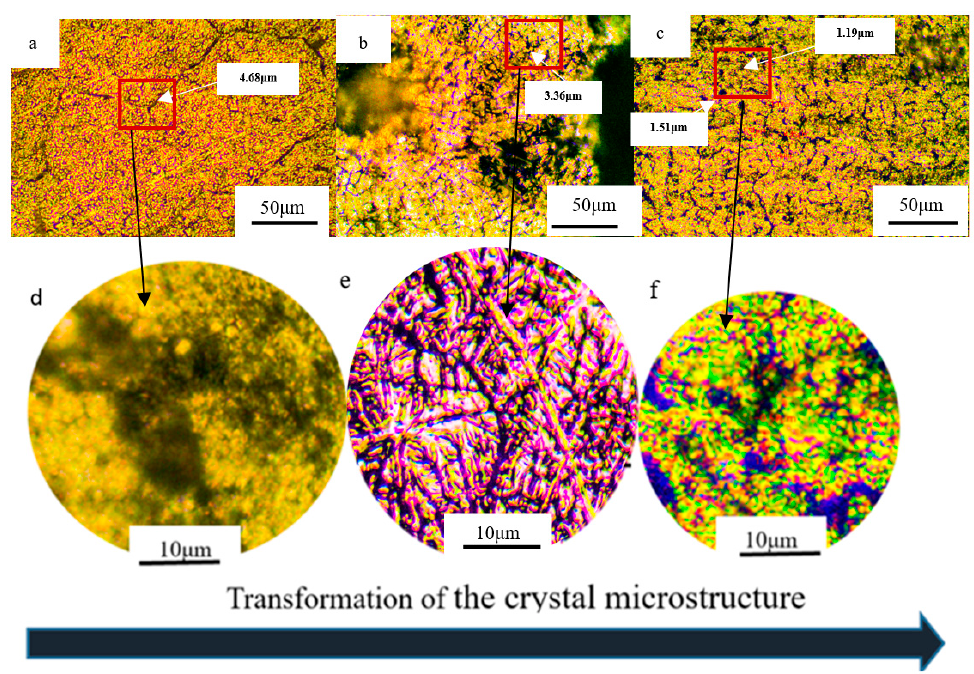
Figure 7. Transformation of the microstructure of crystals under different wire feeding speeds: ( a , d ) 5 m/min; ( b , e ) 5.5 m/min; ( c , f ) 6.5 m/min.